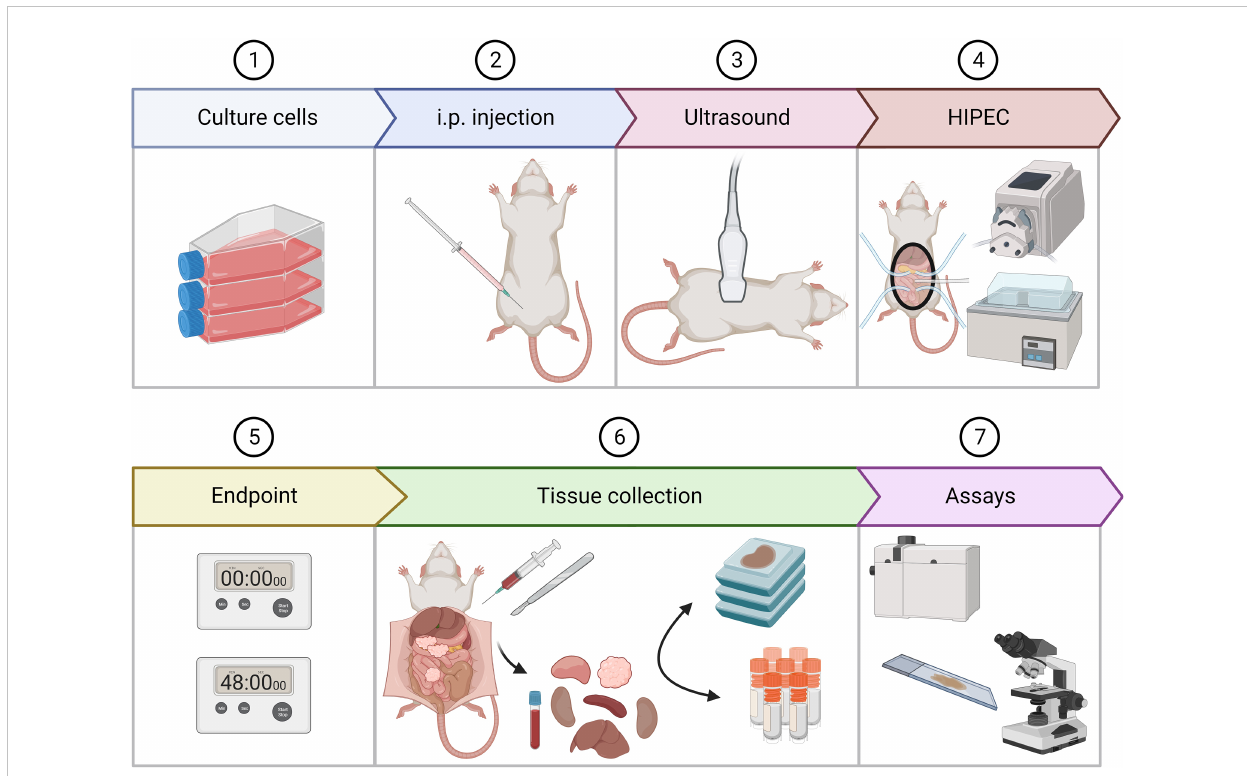
FIGURE 1 An overview of the experimental design. After rats were injected with 2x 10 6 CC-531 cells, tumor outgrowth was followed using ultrasound. When tumors reached a size of 4-6 mm, the HIPEC procedure was performed. After treatment, rats were sacri fi ced 0 or 48 hours after treatment. Upon sacri fi ce, tissue collection was performed. Tumor lesions from 3 different regions, blood and healthy organs were collected in 4% formalin and embedded in paraf fi n or fresh frozen and stored at -80°C. Platinum uptake was measured using inductively coupled plasma mass spectrometry. Apoptosis and proliferation were assessed using immunohistochemistry. This fi gure is created with